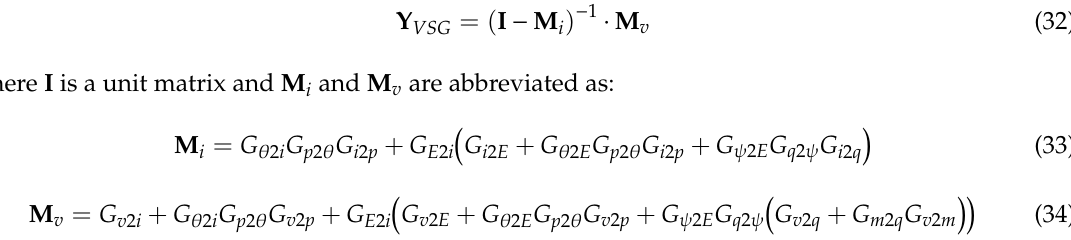
Figure 2. Small-signal relationship in the VSG controlled converter system.